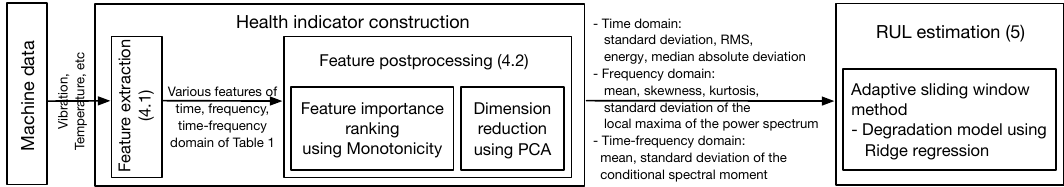
Figure 1. Remaining useful life (RUL) prediction framework for bearings. We add the section number corresponding to the explanation of each